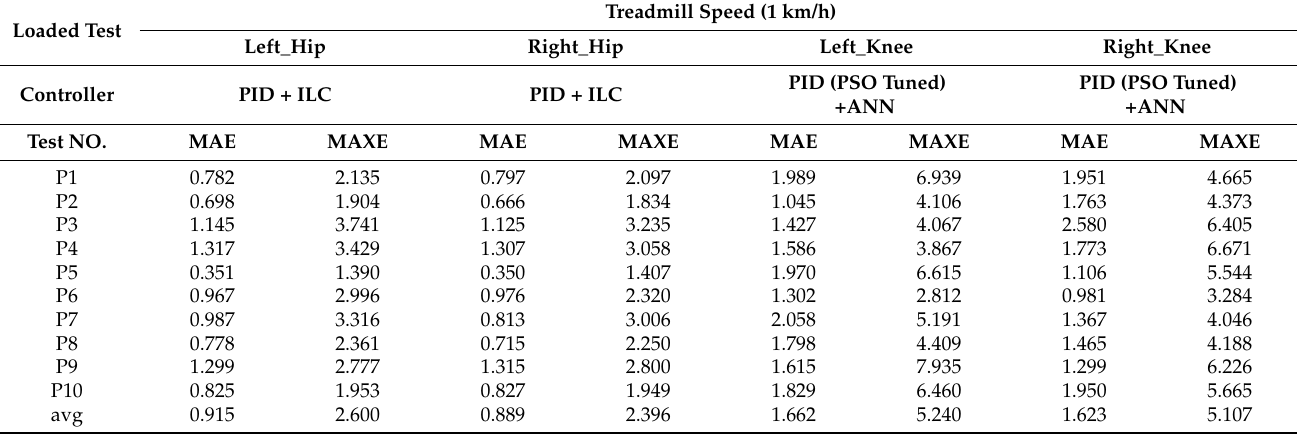
Table 7. Rehabilitation controller performance data for 10